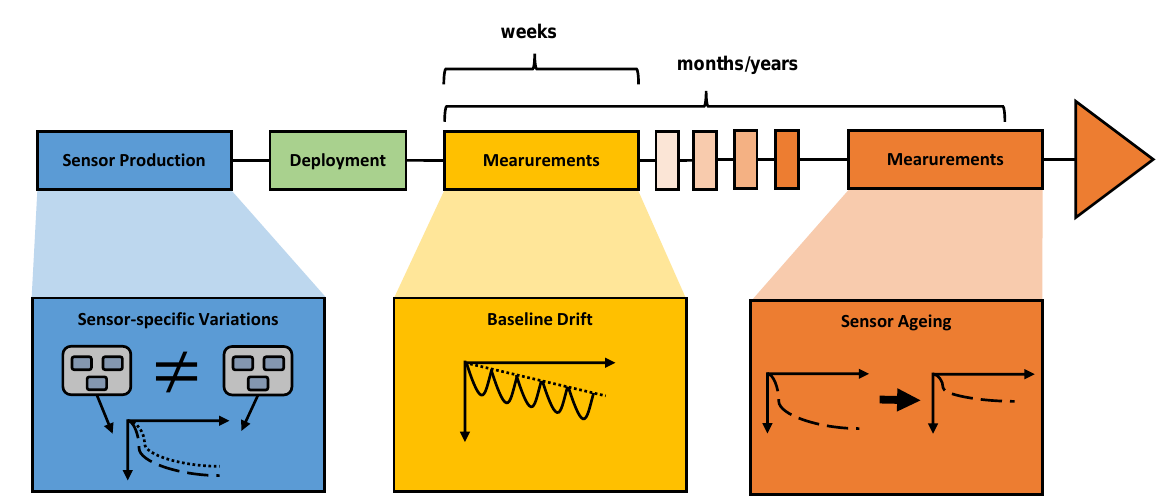
Figure 1. Overview of different types of instabilities happening during the lifetime of a chemiresistive gas sensor. During sensor production, sensor-specific variations can occur, such as the general variability of sensitivities between sensors. After deployment, low-cost devices tend to show a drifting behavior of the measurement baseline in the scope of weeks and months. Over long time scales, sensor ageing can occur, which has a direct impact on the sensitivity of the sensing